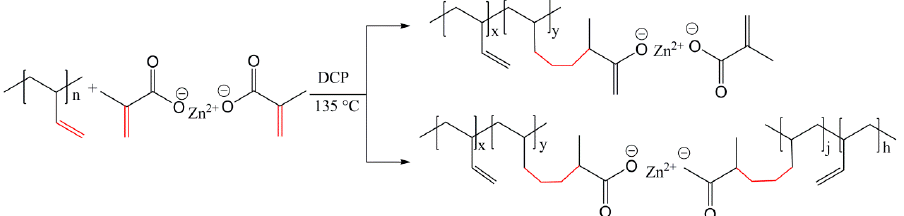
Scheme 1. Reaction between 1,2-PB and zinc methacrylate (ZDMA).